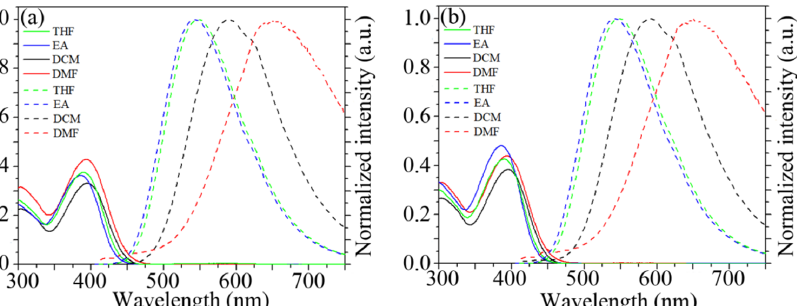
Figure 3. Linear absorption and fluorescence spectra of molecules ( a ) BM-PPPM-C6 and ( b ) BM- PPPM-C12 at a concentration of 1 × 10 − 5 mol/L and cuvette a cuvette width of 1 cm. THF—tetrahydrofuran; EA—ethyl acetate; DCM—dichloromethane; DMF—N,N-dimethylformamide.